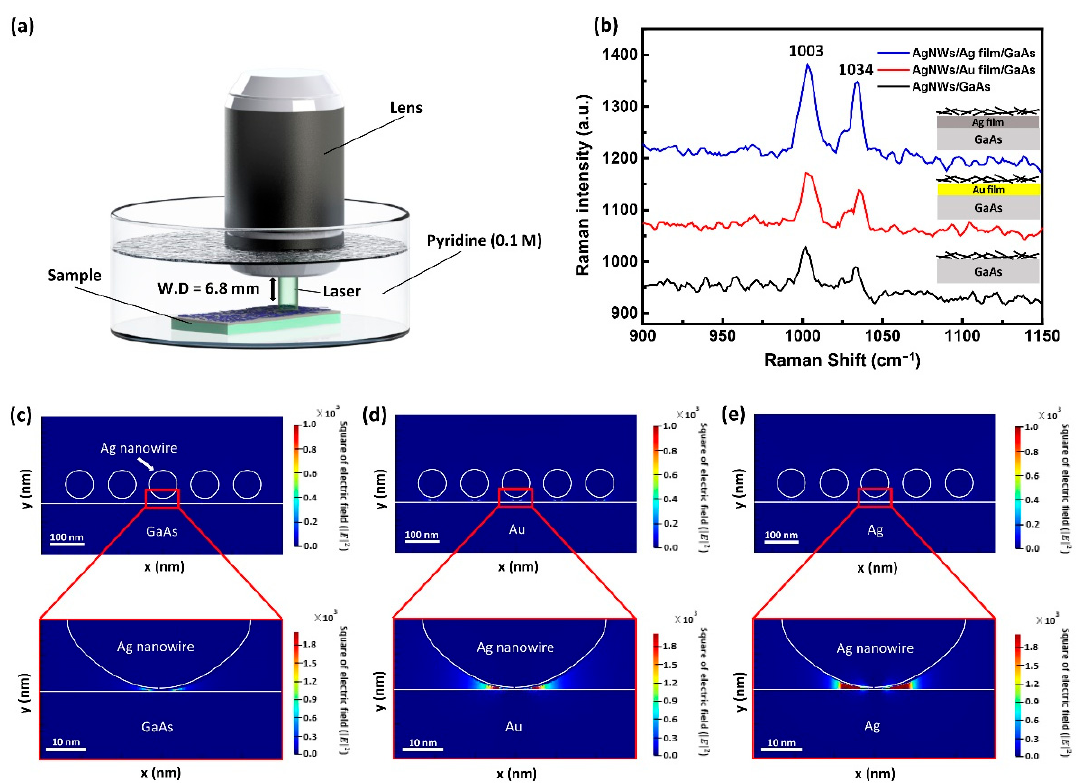
Figure 1. ( a ) Schematic of the Raman measurements with a working distance of 6.8 mm and 0.1 M pyridine solution. ( b ) Comparison of the surface-enhanced Raman scattering (SERS) intensities of Ag nanowires deposited on different metal and dielectric substrates. Finite-difference time domain (FDTD) simulation data showing the cross-sectional electric field distributions (|E| 2 ) for Ag nanowires (AgNWs) deposited on ( c ) GaAs, ( d ) Au, and ( e ) Ag substrates.